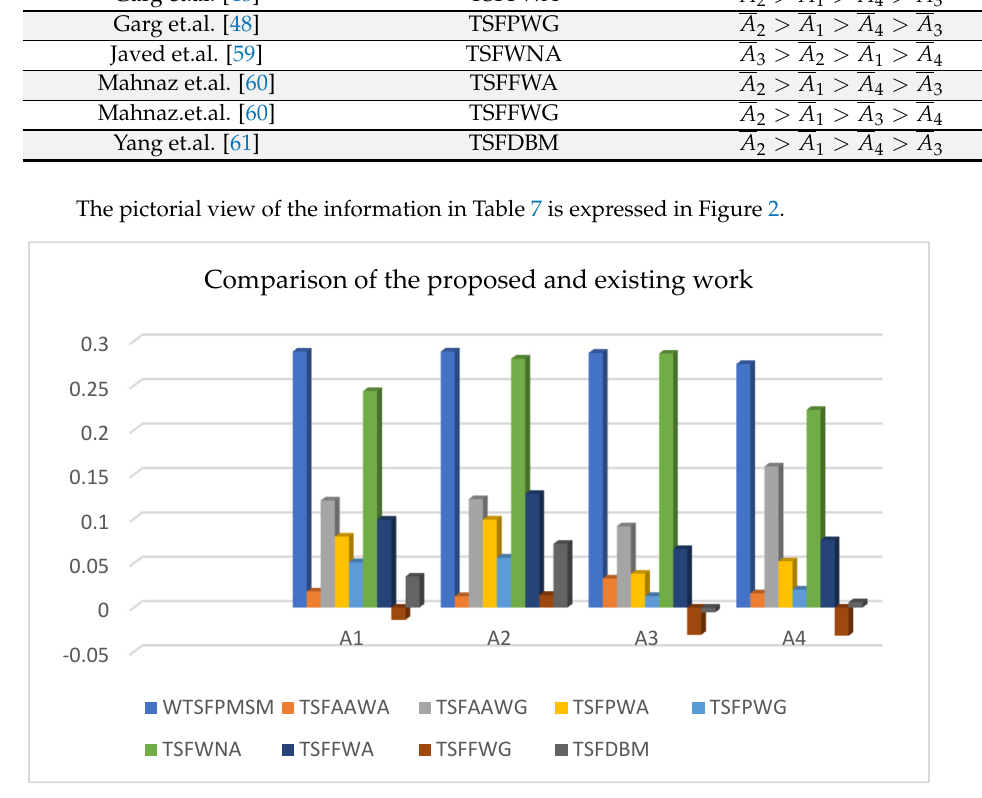
Figure 2. Demonstration of the MSM operating area with different TSFS.